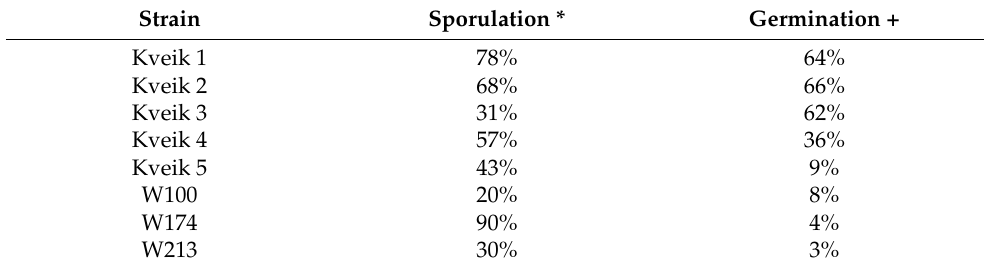
Table 3. Germination efficiency of Kveik and ale yeast spores. Strain Sporulation * Germination +